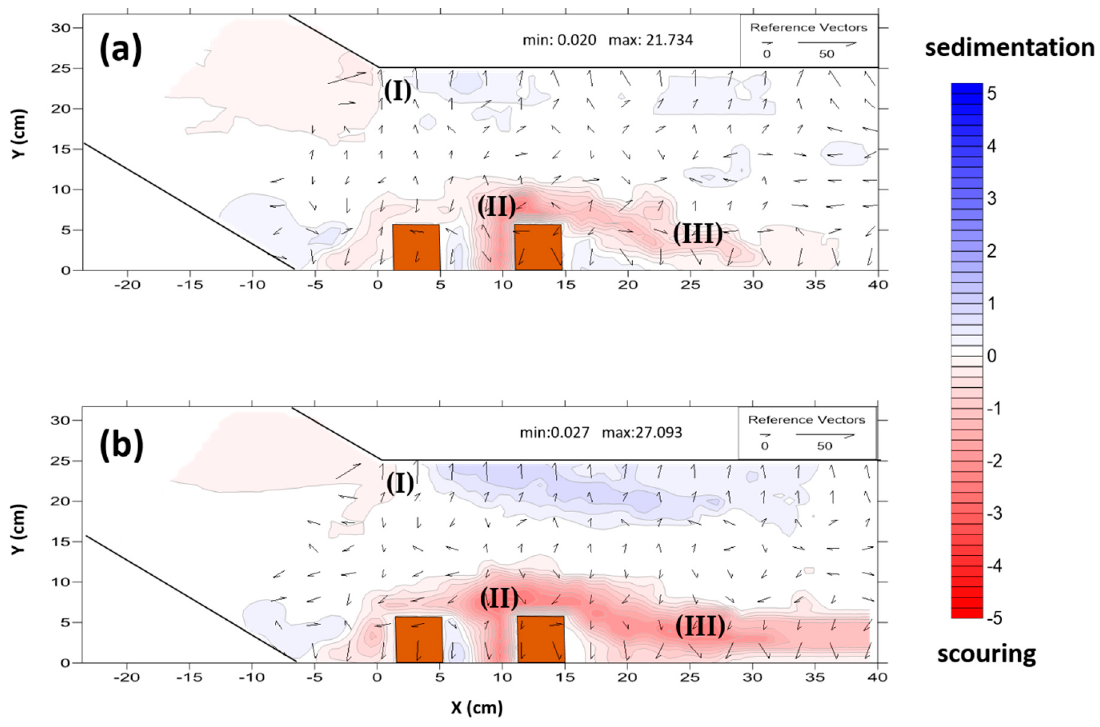
Figure 6. The scouring / sedimentation and velocity of 1 / 30 slope with spur ( a ) 10 year flood recurrence interval and ( b ) 20 year flood recurrence